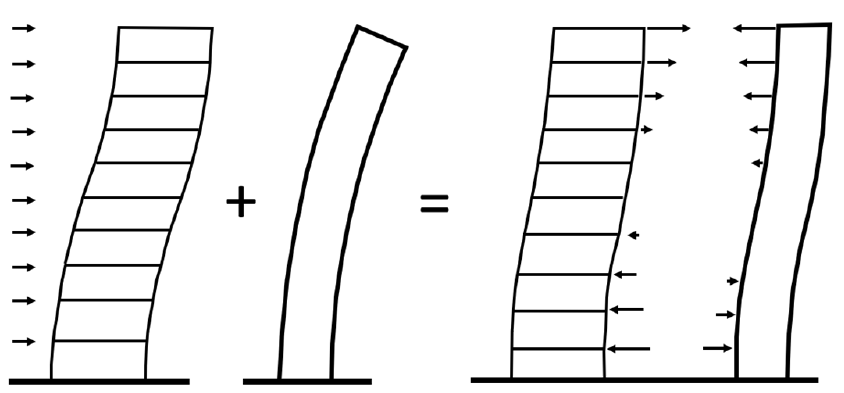
Figure 5. Shear wall (or shear truss)-frame interaction system. (Sketch by K. Al-Kodmany).